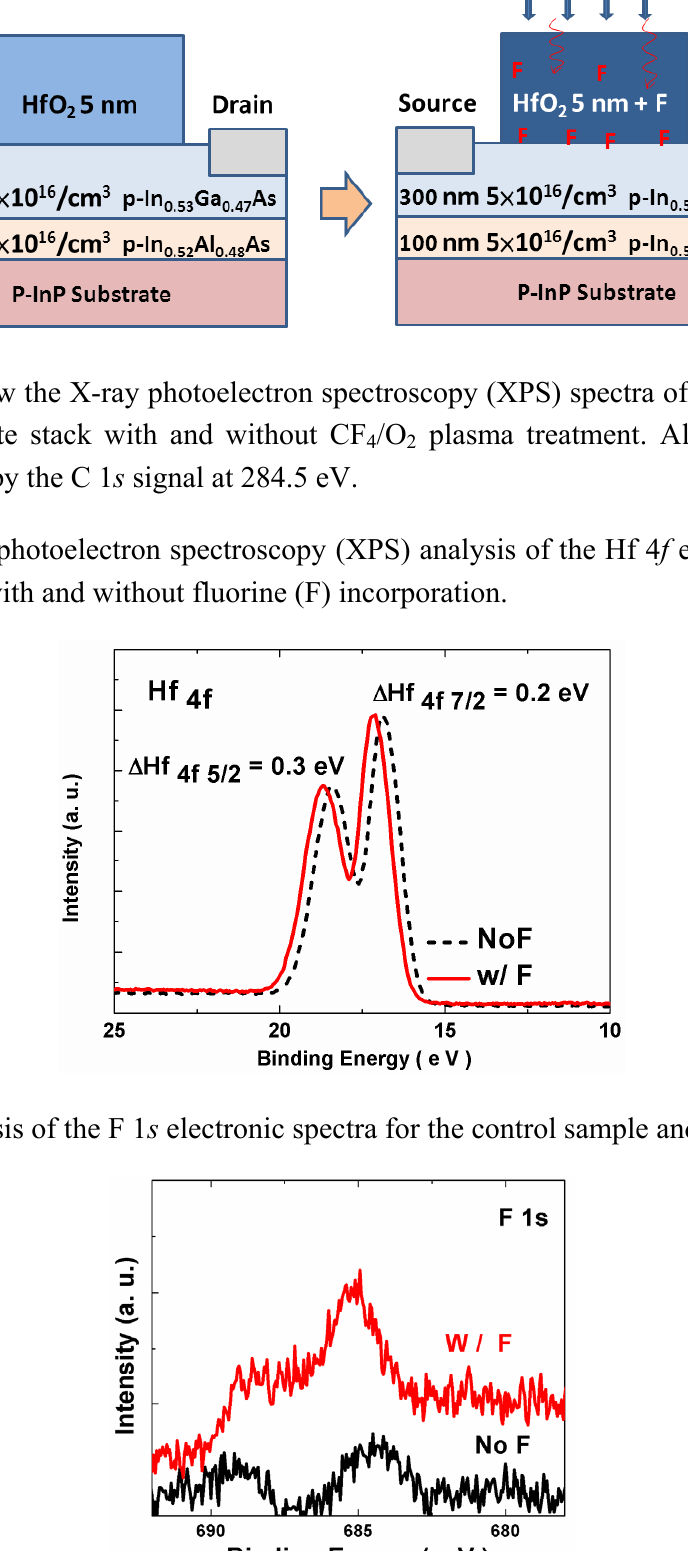
Figure 1. The device cross-sectional structure of HfO were treated in a mixed flow of CF treatment time.